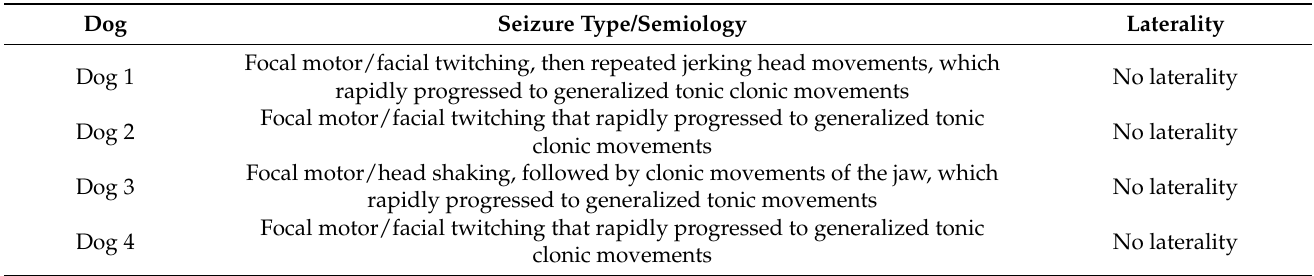
Table 2. Seizures in each